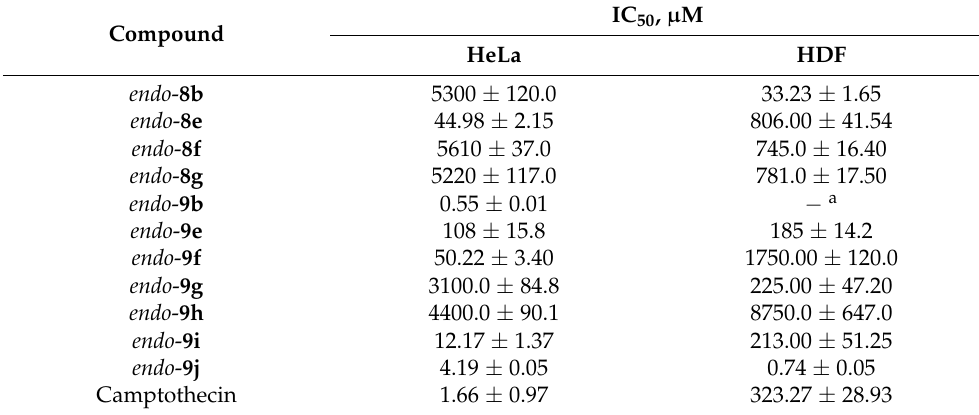
Table 5. Cytotoxic activity (IC 50 ) of compounds endo - 8b , e − g and endo - 9b , e − j against HeLa and HDF cell lines.